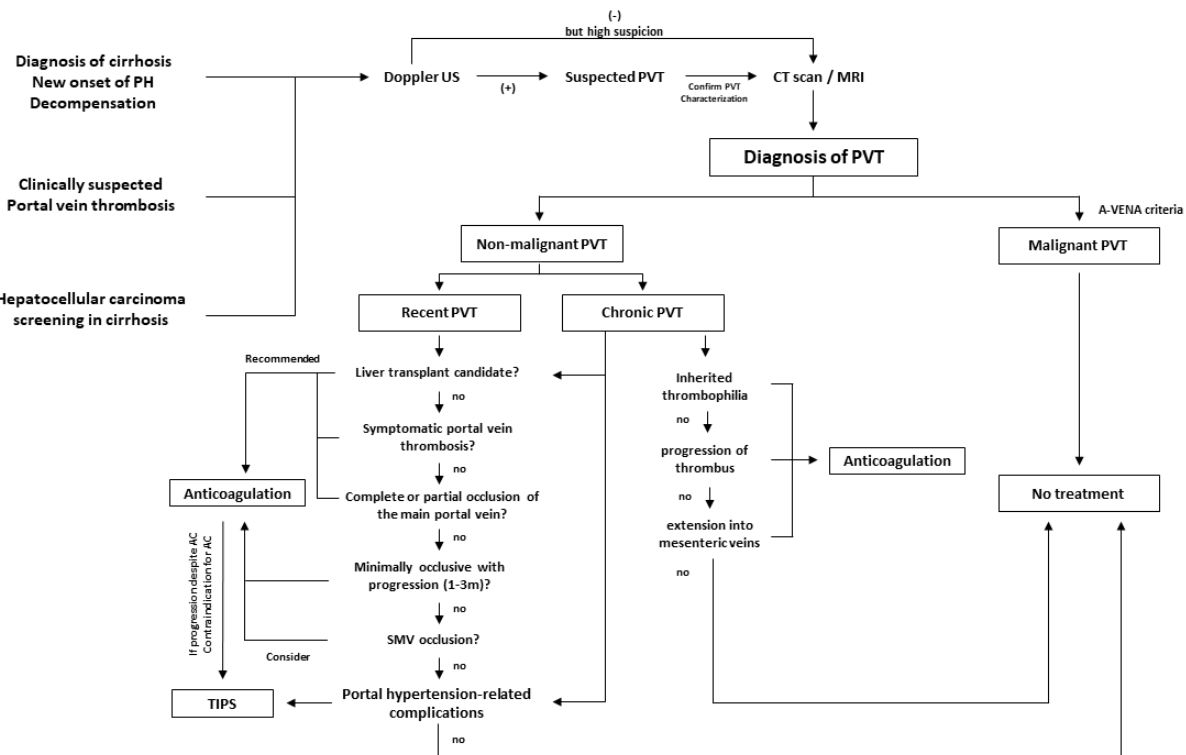
Figure 5. The algorithm for the management of portal vein thrombosis in patients with cirrhosis according to the Baveno VII consensus recommendations.